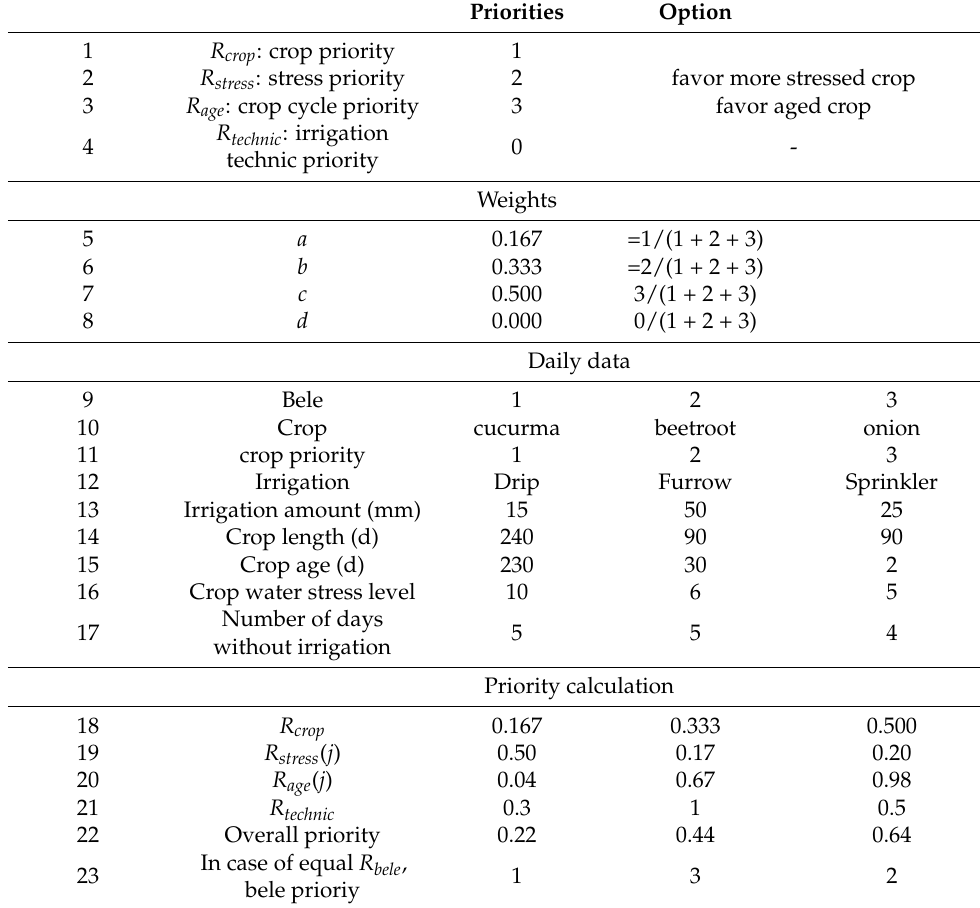
Table 1. An example of the algorithm to determine the priority between the different beles to be irrigated. In this case, the bele irrigated is bele 1 as it has the lowest (cid:60) . See text for